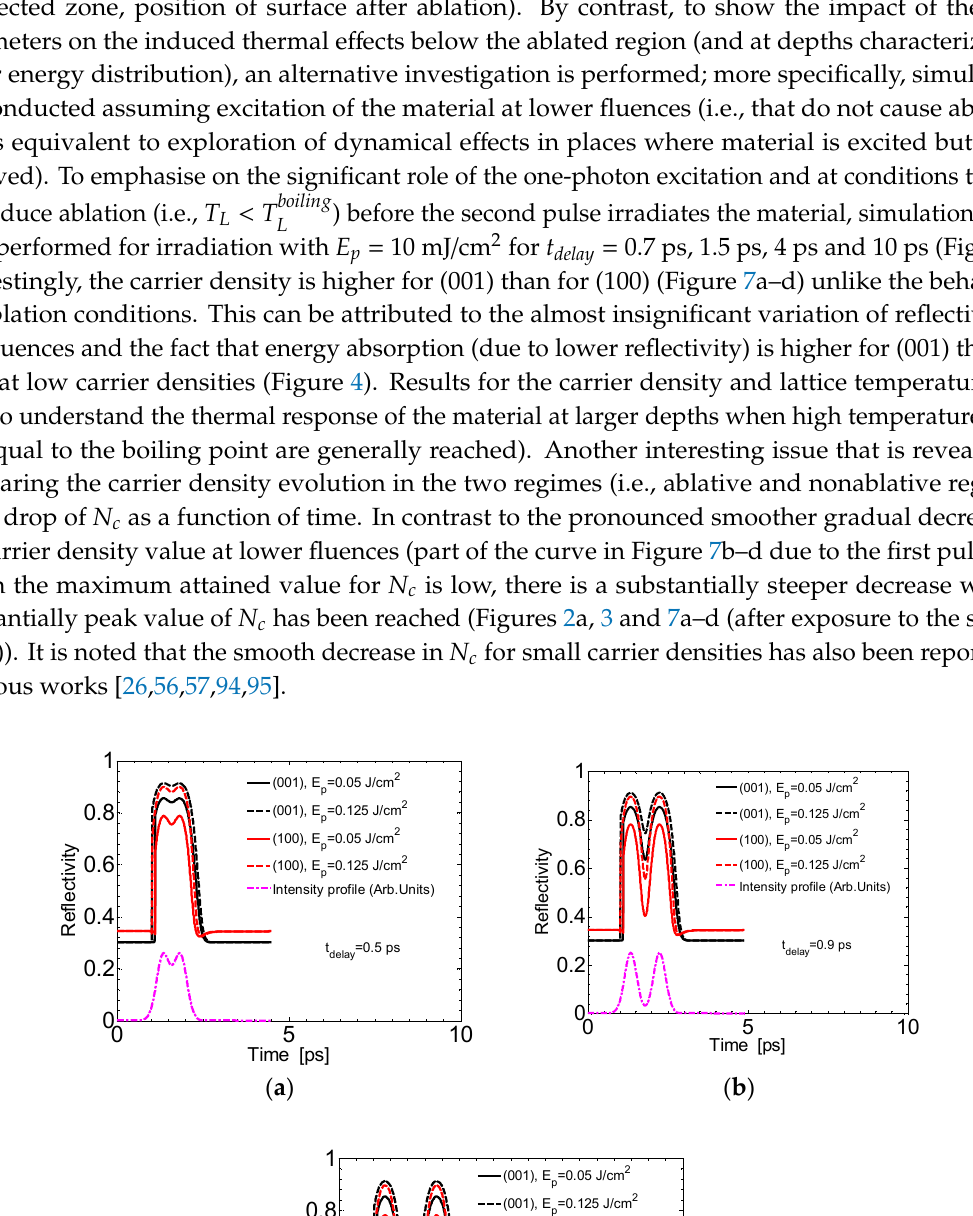
Figure 4. Evolution of reflectivity for E p = 50 mJ / cm 2 and 125 mJ / cm 2 for (001) and (100) crystal orientation at t delay = 0.5 ps ( a ), 0.9 ps ( b ), and 1.5 ps ( c